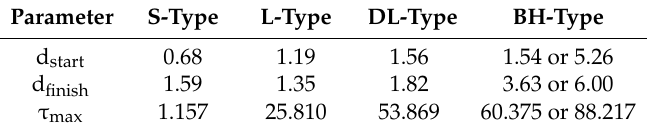
Table 2. Critical parameters extracted from the mechanical SMA pullout tests in terms of SMA geometric modifications. (d start : the mechanical displacement at the starting point of the debonding stage in the Ni/Ti SMA pullout test, d finish : the mechanical displacement at the finishing point of the debonding stage in the Ni/Ti SMA pullout test, τ max : the mechanical force (or stress) at the debonding stage).